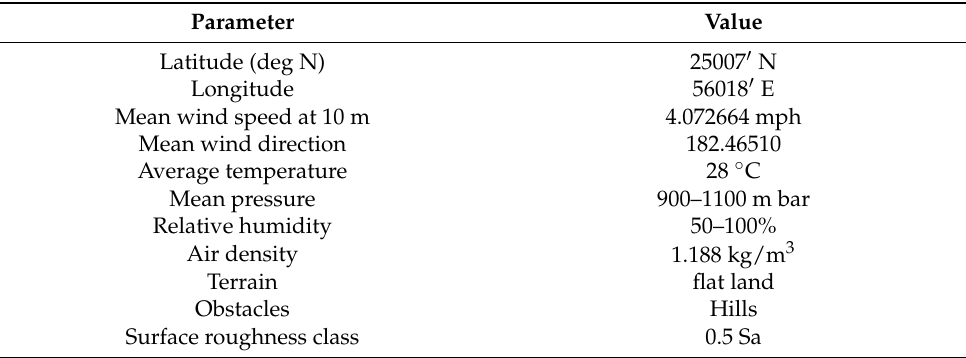
Table 1. Physical parameters of Fujairah site